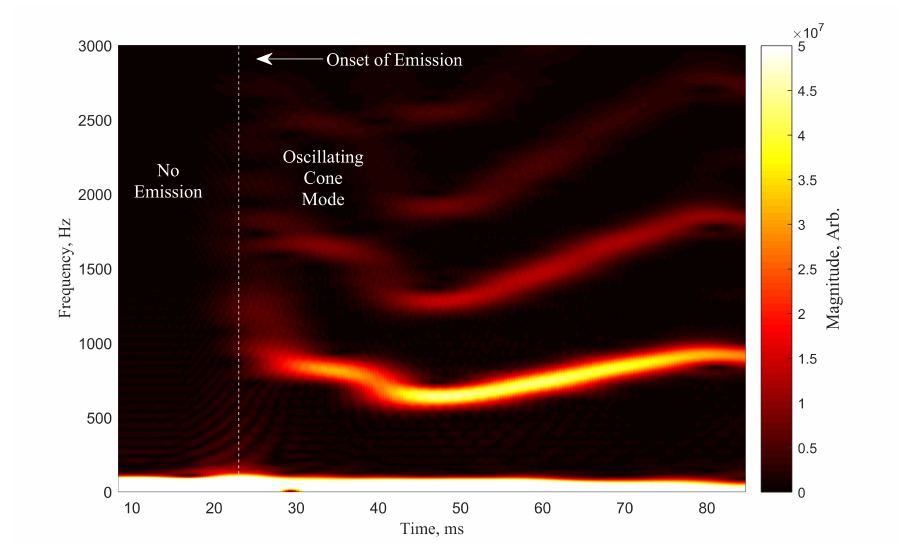
Figure 10. Narrowband spectrogram of aggregate pixel intensity for the video of an EMI-Im electrospray during voltage-induced startup. The approximately 100Hz frequency bands correspond to vibration of the setup. Onset of emission is denoted by the vertical dotted line at ∼ 23ms. The ∼ 800Hz band corresponds to the characteristic frequency of the intermittent cone-jet mode. Bands above 1kHz correspond to whipping-jet breakup that occurs during the relaxation phase of pulsation. The pulsation band appears to deviate by ∼ 200Hz over